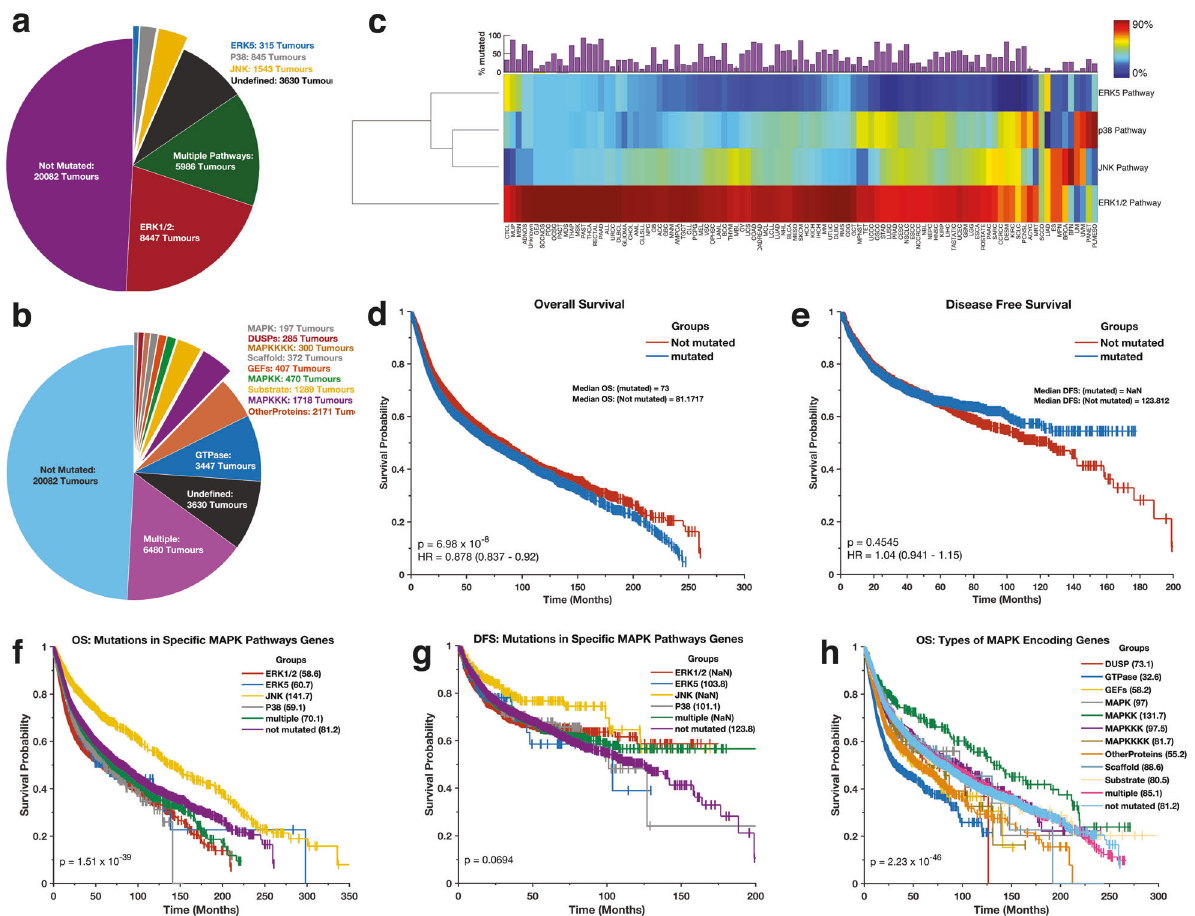
Fig. 2 Mutations of the MAPK pathways across cancer types and disease outcomes. a Pie chart indicating the proportions and the actual numbers of mutations within the genes of each MAPK pathway signalling module (ERK1/2, p38, JNK and ERK5 pathway). Note: the “ unde fi ned group ” relates to tumour samples that were pro fi led by a targeted sequencing approach for which the sequencing panel included only some of the MAPK pathway genes that are known (1) oncogenes, and/or (2) tumour suppressor genes, and/or (3) frequently mutated in cancer (please refer to the Methods section for details). b Pie chart showing the proportions and the actual numbers of mutations to genes that encode different classes of MAPK proteins. c Clustering of the 101 distinct cancer types based on the proportions of samples with mutations in each of the four MAPK signalling pathway modules (Excluding TP53 mutations). Redder colour intensities denote higher percentages of mutations. The clustergram was produced using unsupervised hierarchical clustering with the cosine distance metric and complete linkage. The coloured bars on the heatmap show the overall frequency of gene mutations within the samples belonging to each cancer type represented within each column of the heatmap. Kaplan – Meier curve of the overall survival periods ( d ) and disease-free survival periods ( e ) of patients af fl icted with tumours with and without mutations in MAPK pathway genes. Kaplan – Meier curve of the overall survival periods ( f ) and disease-free survival periods ( g ) of patients with tumours that have mutations to genes of only a single MAPK signalling pathway module (ERK1/2, p38, JNK and ERK5 pathway), mutations in genes of multiple MAPK signalling pathway modules, and no mutated MAPK pathway genes. The numbers in parenthesis show the median OS or DFS periods. NaN (Not a Number) represent unde fi ned median OS or DFS period in that >50% of patients survived beyond the study duration. h Kaplan – Meier curve of the overall survival periods of patients with tumours that have mutations to genes that encode the various classes of MAPK for patients with tumours that had mutations in the MAPK pathway module genes of the ERK1/2 pathway (median survival = 58.6 months) versus those of the ERK5 pathway (60.7 months; p = 0.4); the ERK1/2 pathways genes versus those of the p38 pathway (59.1 months; p = 0.078); and the ERK5 pathway genes versus those of the p38 pathway ( p = 0.74; Fig. 2f; also see Supplementary File 2 for all pairwise comparisons).